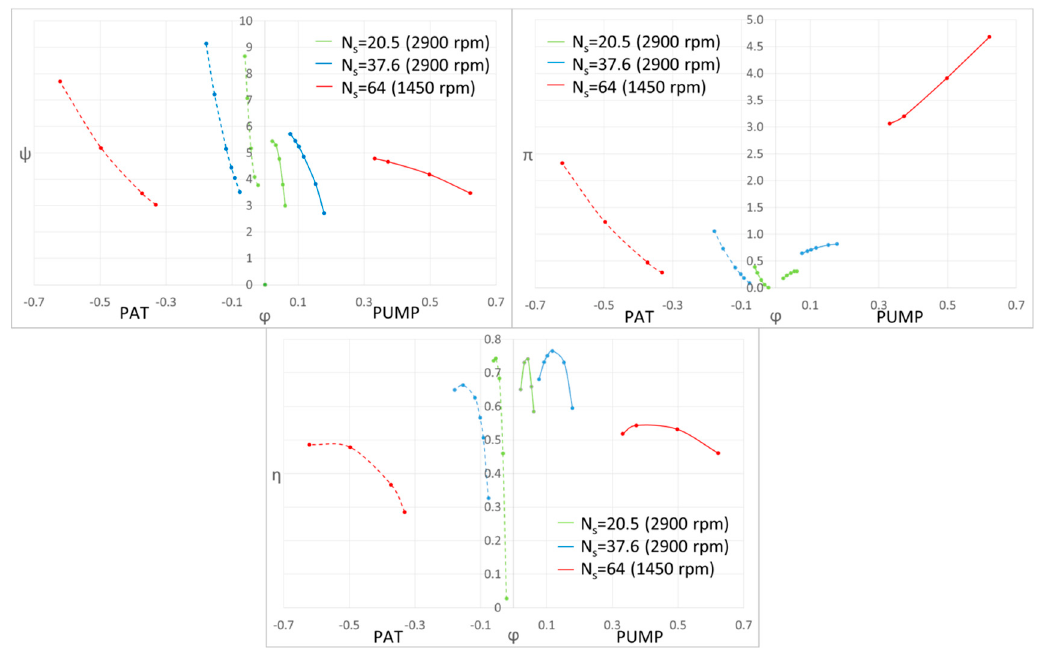
Figure 9. Specific head, specific power and efficiency.